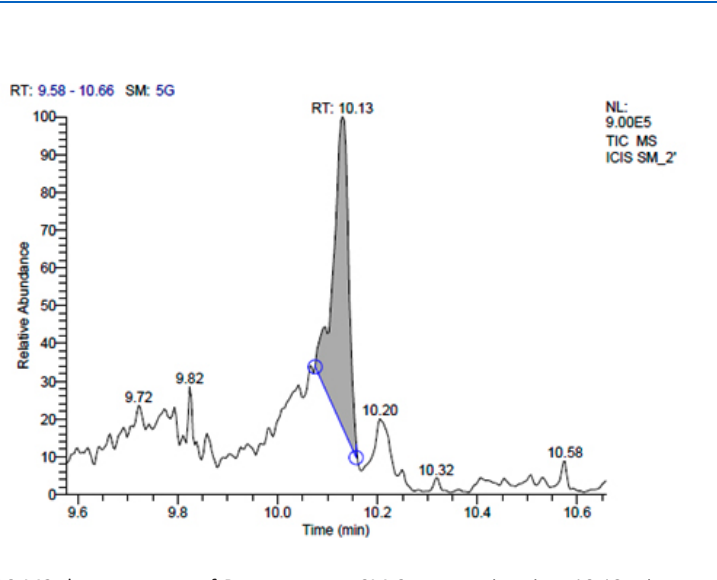
bacteria(j) GC-MS chromatogram of P. pentosaceus SM-2 at retention time 10.13 Fig. 1. GC-MS chromatograms of metabolites secreted by Lactic acid